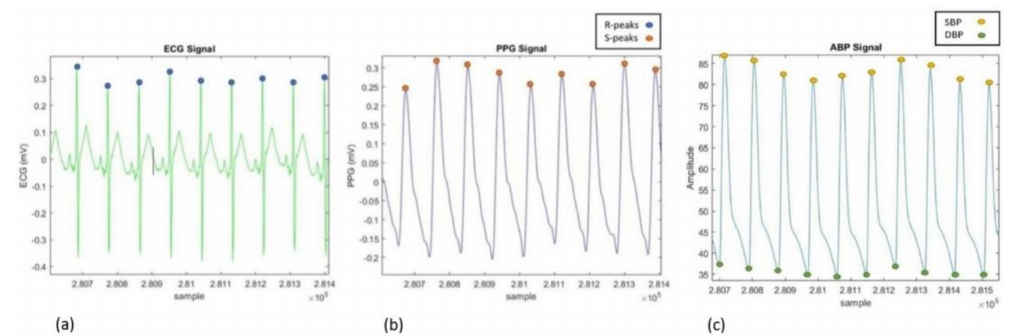
Figure 9. ( a ) R − peaks, ( b ) S − peaks, and ( c ) maxima and minima detection in signals from the MIMIC III